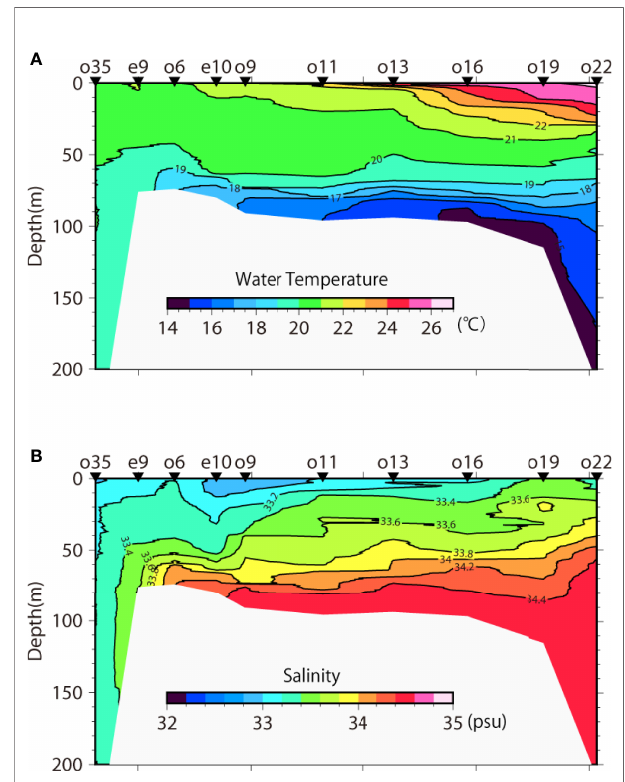
FIGURE 5 | Observed north – south cross-sections of (A) water temperature and (B) salinity from July 11 to 12 at the stations shown as green dots in Figure 1B .